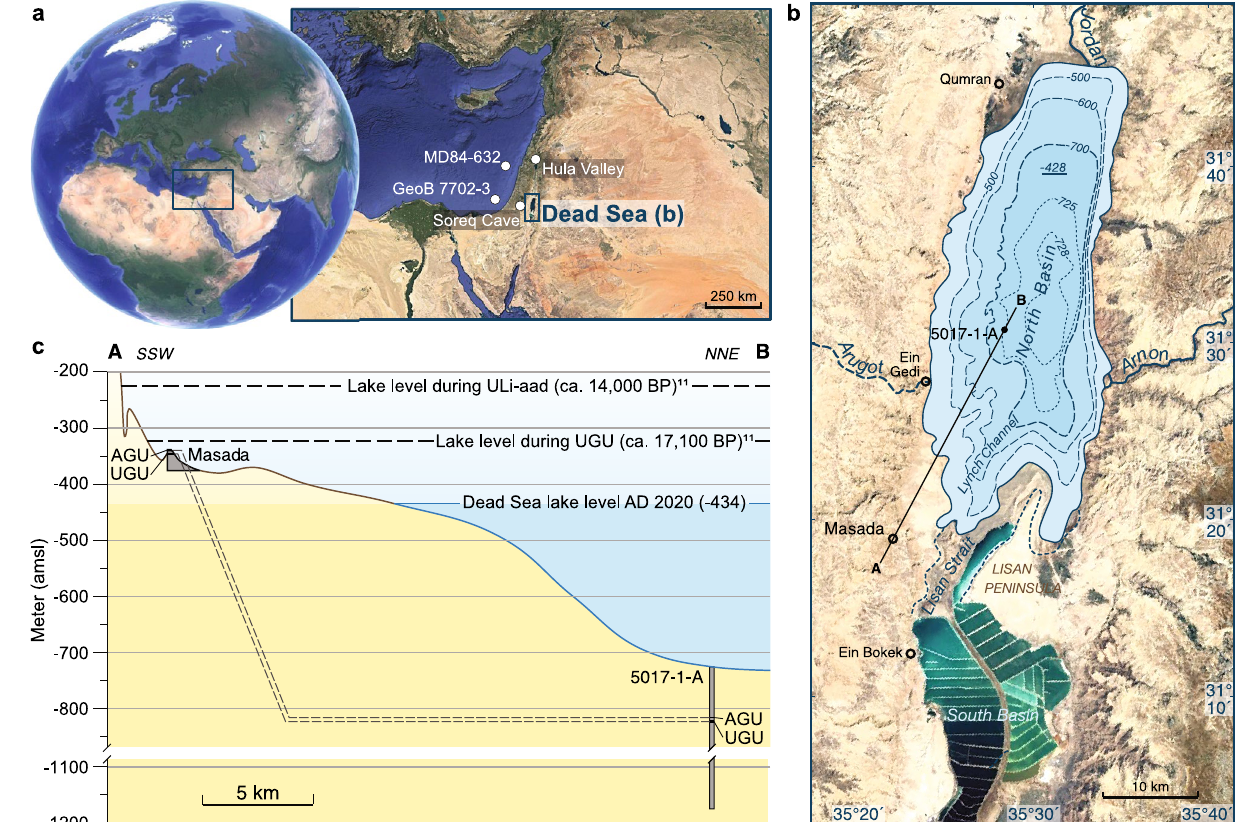
Figure 1. Dead Sea location, sampling sites and lake levels of the investigated time interval. ( a ) Satellite images (Map data: Google Earth, SIO, NOAA, U.S. Navy, NGA, GEBCO) of the location of the Dead Sea and other sites (Soreq Cave 18 , Hula Valley 19 , MD84-632 20 , GeoB 7702-3 21 ) discussed in this study. ( b ) Bathymetric map and satellite image (Map data: Google Earth, SIO, NOAA, U.S. Navy, NGA, GEBCO) of the Dead Sea with sampling sites onshore (Masada) and in the deep lake center (core 5017-1-A). ( c ) Topographic/ bathymetric profile